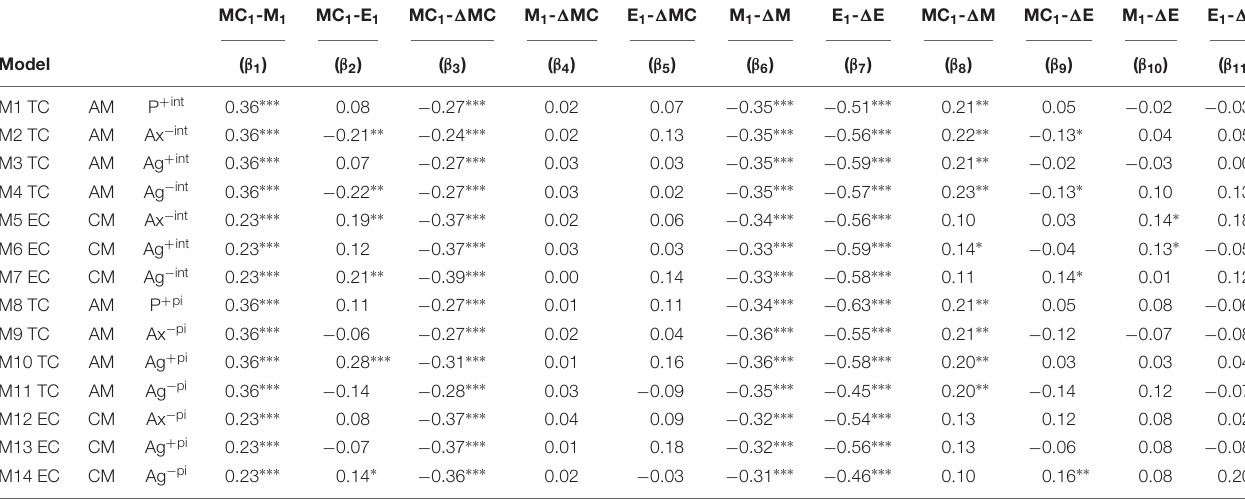
TABLE 3 | Standardized path coefficients for relationships between motivational climate (MC), motivation regulations (M), and emotions (E). MC 1 -M 1 MC 1 -E